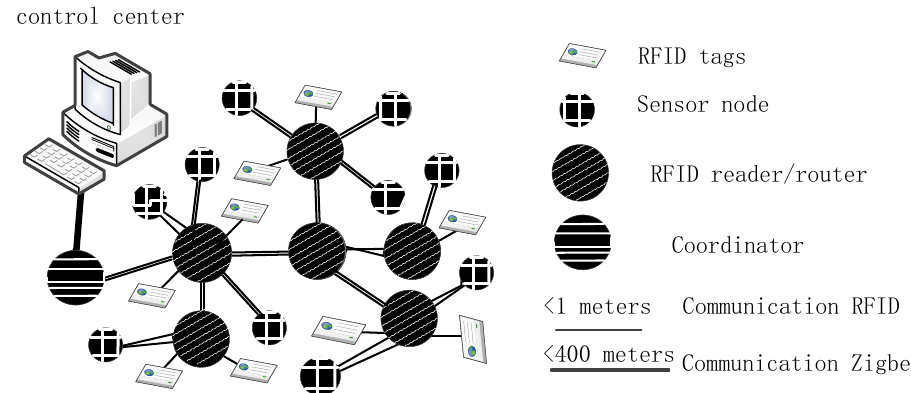
Figure 2. Communication structure of the proposed hybrid system.